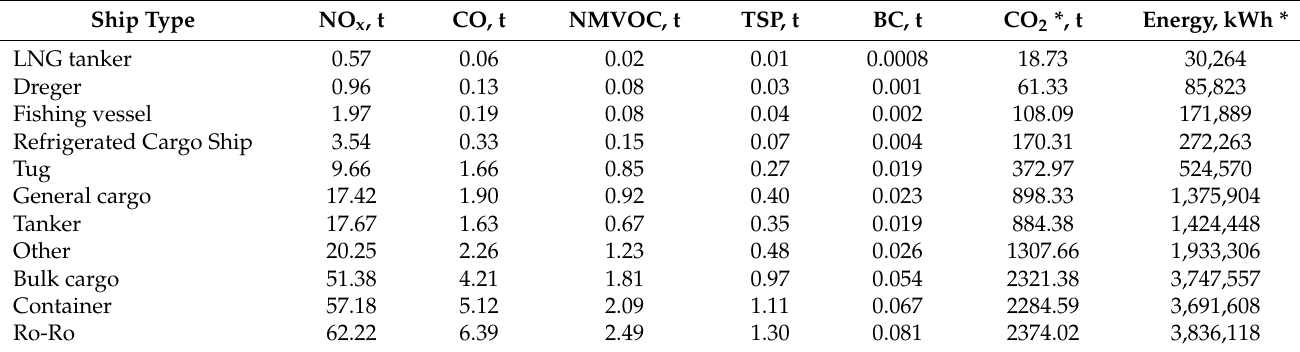
Table 1. Average sizes of all emissions according to ship